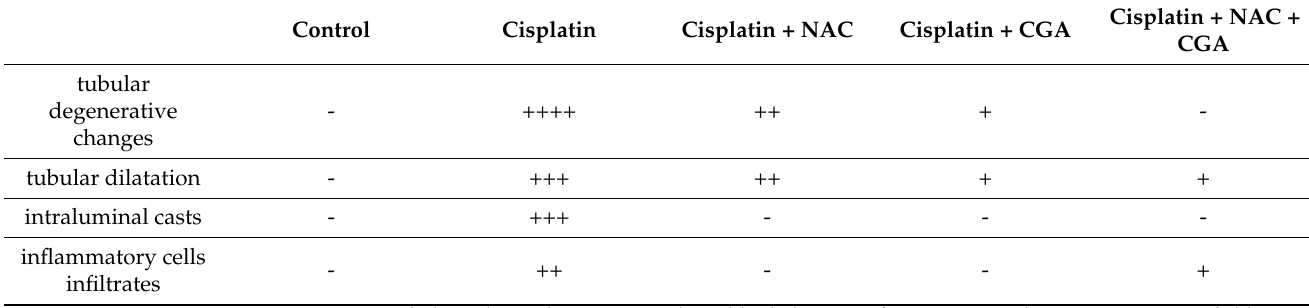
Table 2. Scoring of Histopathological Tissue Damage in Different